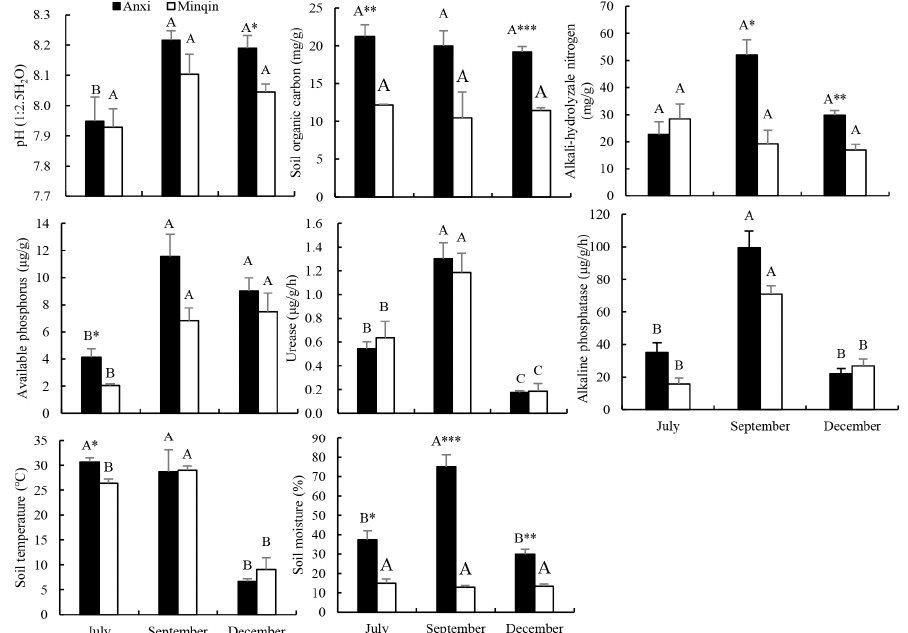
Figure 4. Spatial and temporal distribution of soil factors of L. ruthenicum . p < 0.05, significant differences among different mouths marked with different letters; p < 0.05, significant differences among sampling sites marked with *; * indicates a significant difference at P < 0.05, ** indicates a significant difference at p < 0.01, and *** indicates a significant difference at P < 0.001.